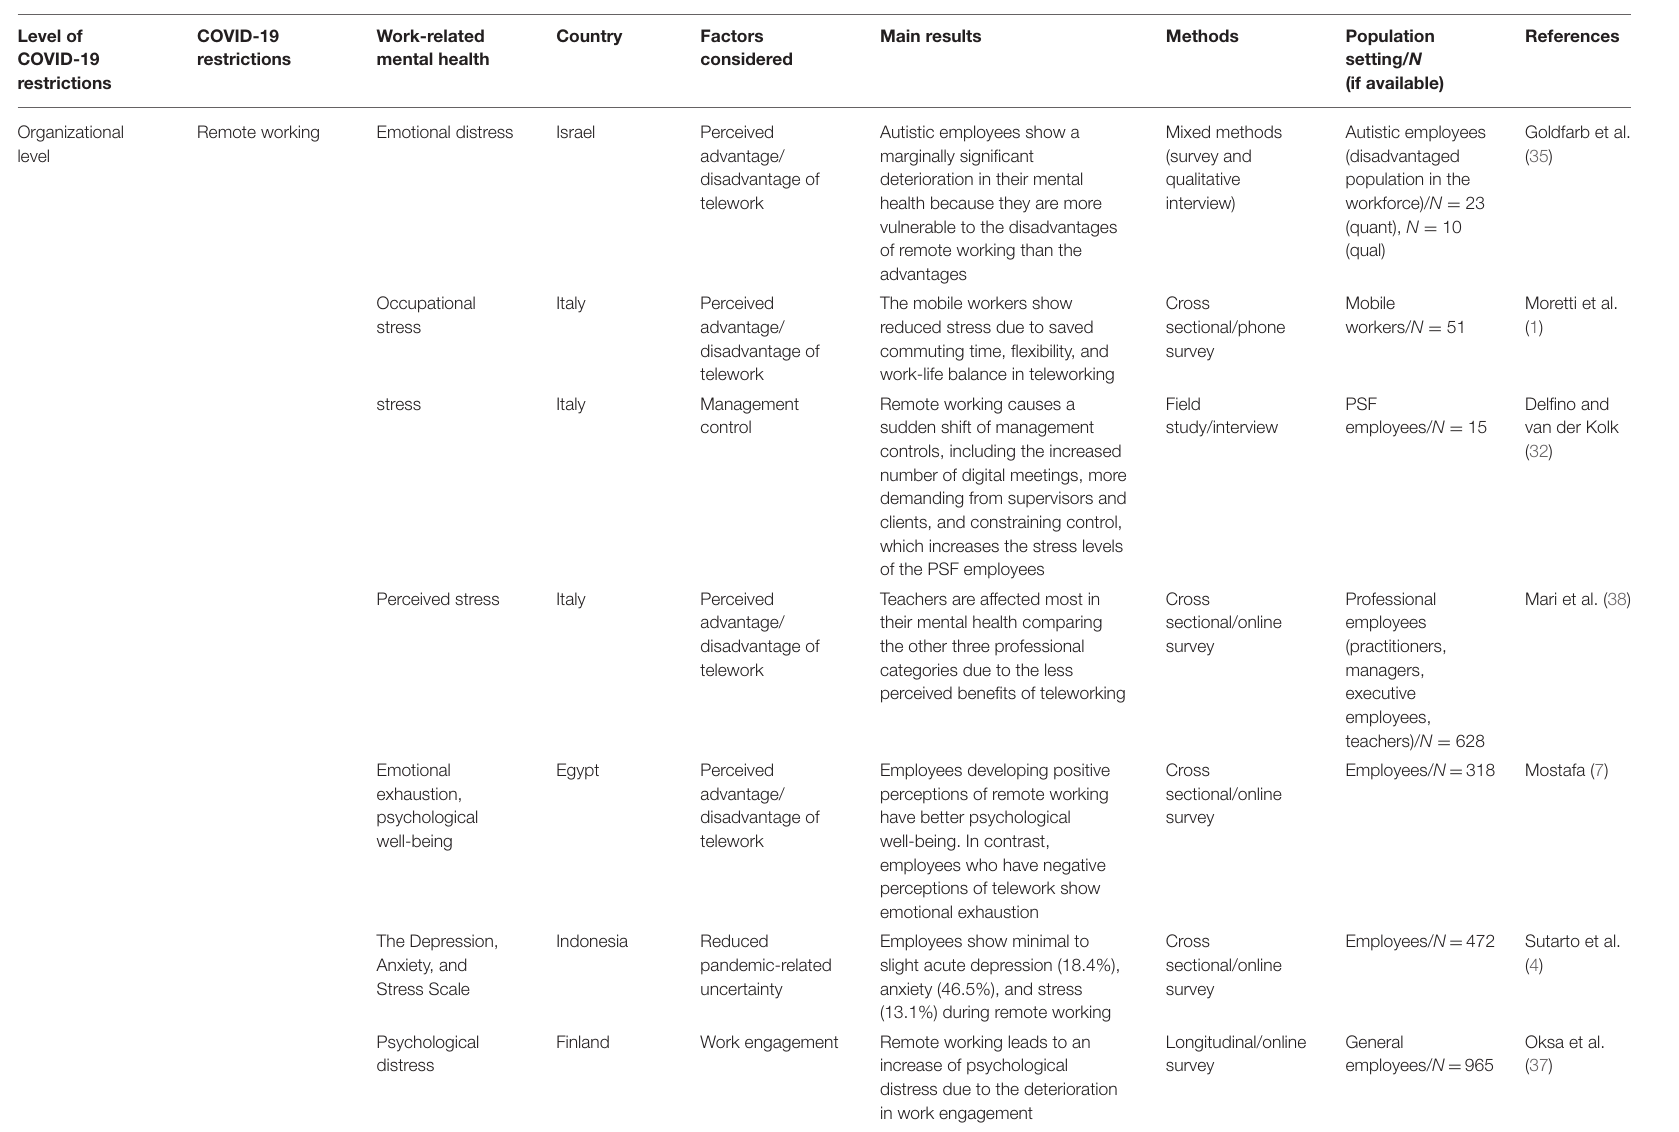
TABLE 1 | Description of included